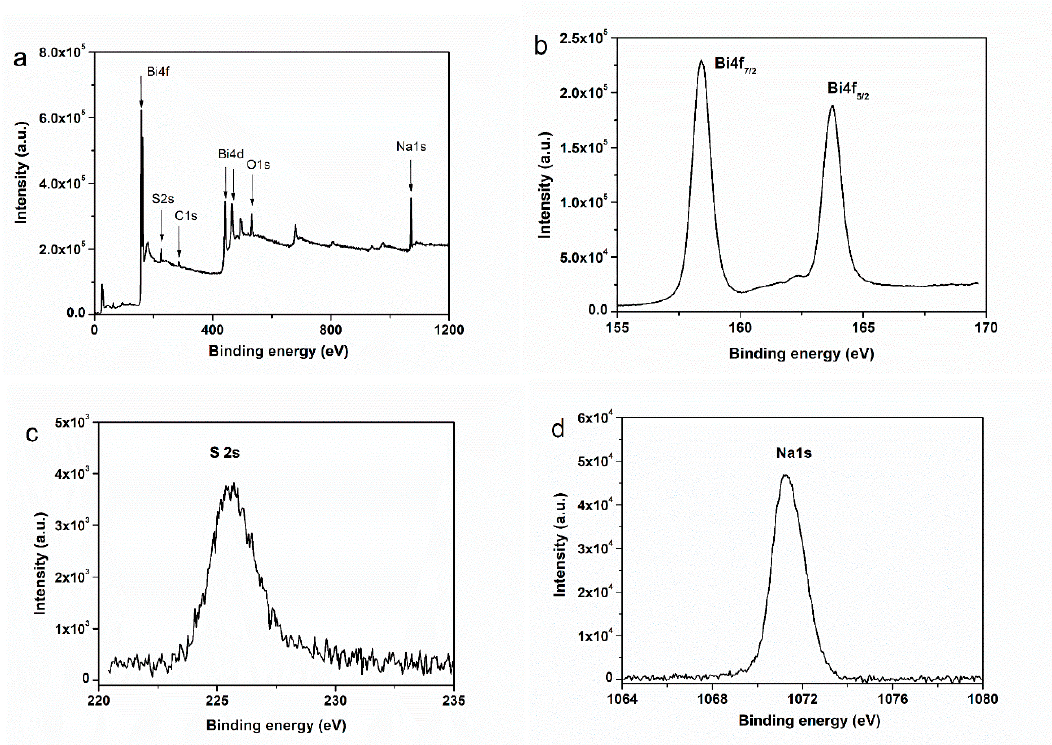
Figure 3. XPS spectra patterns of ( a ) full span, ( b ) Bi4f, ( c ) S2s, and ( d ) Na1s.